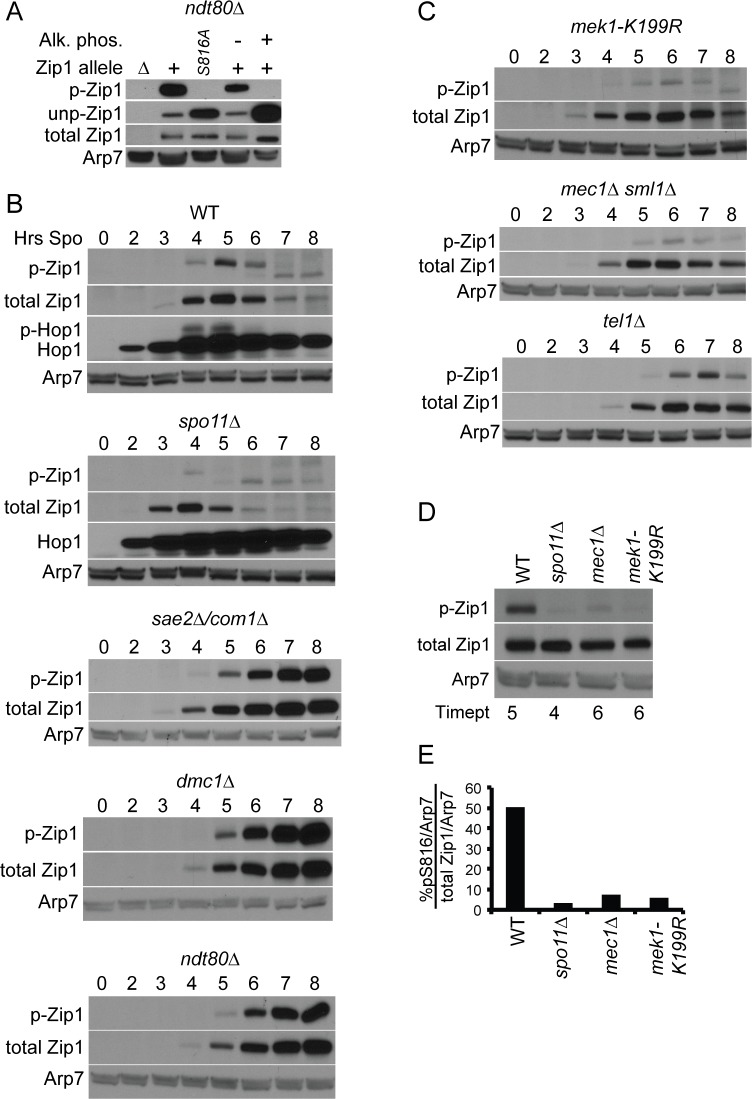
Phosphorylation of Zip1 S816 monitored under different genetic conditions.(A) Protein extracts were generated from ndt80Δ (NH2234::p382), ndt80Δ zip1Δ (NH2234::pRS304), and ndt80Δ zip1-S816A (NH2234::p382-S816A) after 8 h in Spo medium and probed with antibodies specific for Zip1 p-S816 (indicated as p-Zip1) or unphosphorylated Zip1 (indicated as unp-Zip1). In addition, total Zip1 was detected using a polyclonal antibody that recognizes both forms of the proteins. Phosphatase experiments used alkaline phosphatase (AP). Antibodies against Arp7 (SGD S000006238) were used throughout as a loading control [27]. (B) Proteins from mutants defective in different steps of recombination were probed with antibodies that recognize either Zip1 pS816 or total Zip1 protein. For the WT (NH716) and spo11Δ (NH1055) strains, Hop1 phosphorylation was used to indirectly assay DSB formation [43]. (sae2Δ /com1Δ = NH1054; dmc1Δ = NH792; ndt80Δ = NH2188) (C) Extracts from mek1-K199R (NH566::pLT11::pXC6), mec1Δ sml1Δ (SGD S000004523) (NH774), and tel1Δ (NH772) diploids were monitored for the presence of Zip1 p-S816 and total Zip1 as in Panel B. (D) Time points with the highest amount of total Zip1 from the indicated mutant time courses shown in Panels B and C were run on the same gel and assayed for the presence of Zip1 p-S816 or total Zip1 to allow for direct comparison. (E) Quantification of the fraction of Zip1 phosphorylated on S816 in Panel D. Total Zip1 and pS816 signals were normalized to the Arp7 signal in the same lane using scanned images of the gel with the ImageQuant 7.0 software and the percent of phosphorylated Zip1 was calculated as pS816/Arp7pS816/Total Zip1/Arp7Total Zip1 *100.